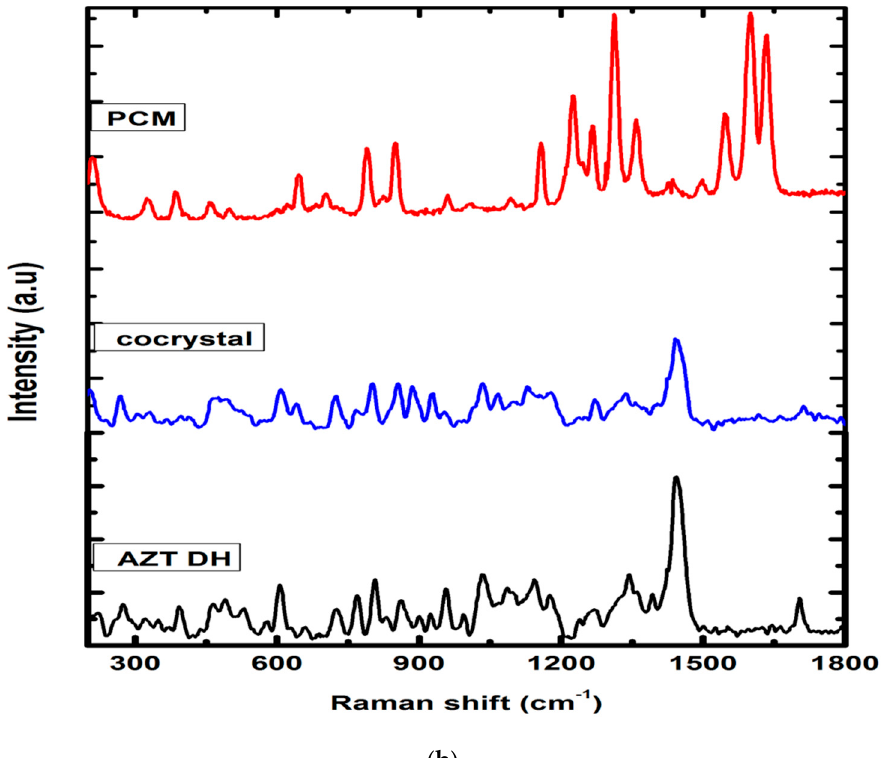
Figure 4. ( a ) Raman spectra of AZT DH, PCM and cocrystal range (2700–3100 cm − 1 ). ( b ) Raman spectra of PCM, AZT DH and the cocrystal range (500–1750 cm − 1 ).